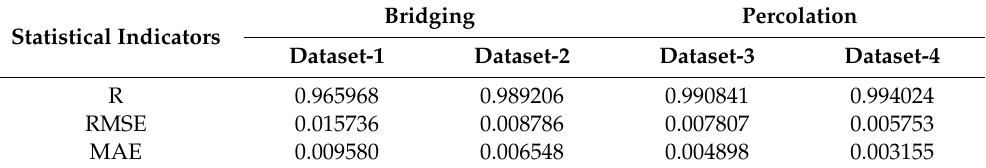
Table 5. Statistical performances of FNN model (for testing data) along the depth (z-direction).